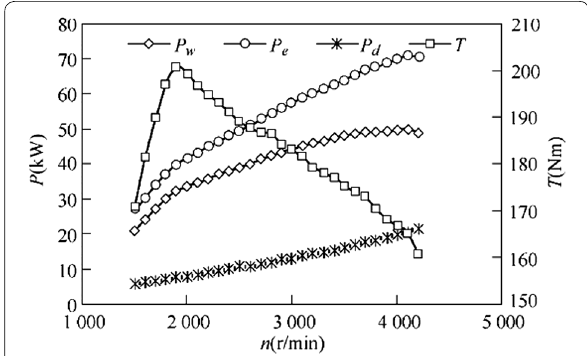
Figure 5 Full load characteristics obtained on the chassis dynamometer (description in the